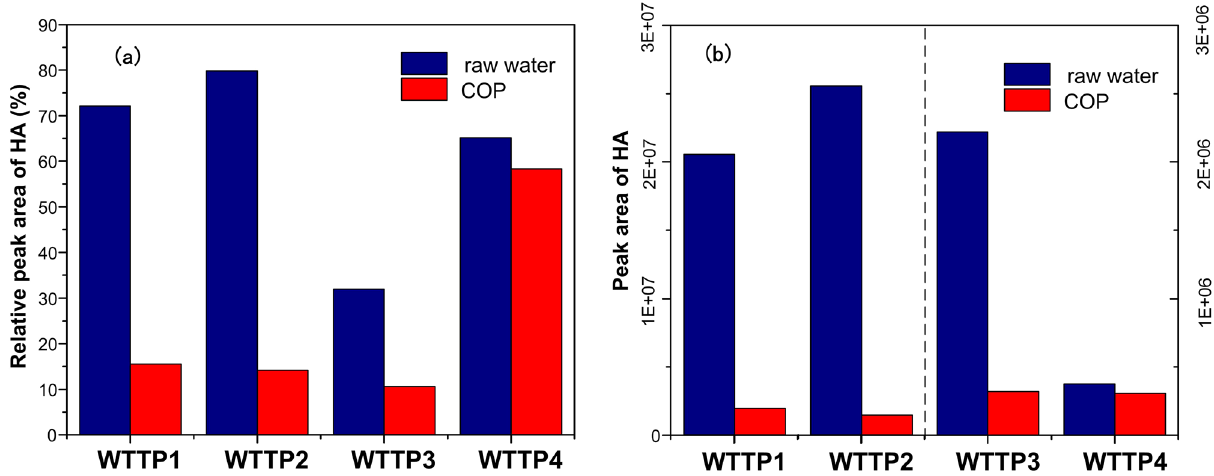
Figure 8. Changes of ( a ) relative peak area and ( b ) peak area of HA before and after COP